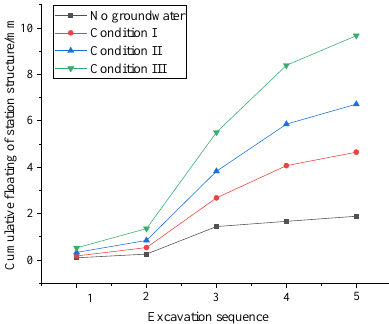
Figure 6. Cumulative deformation of earthwork excavation station.